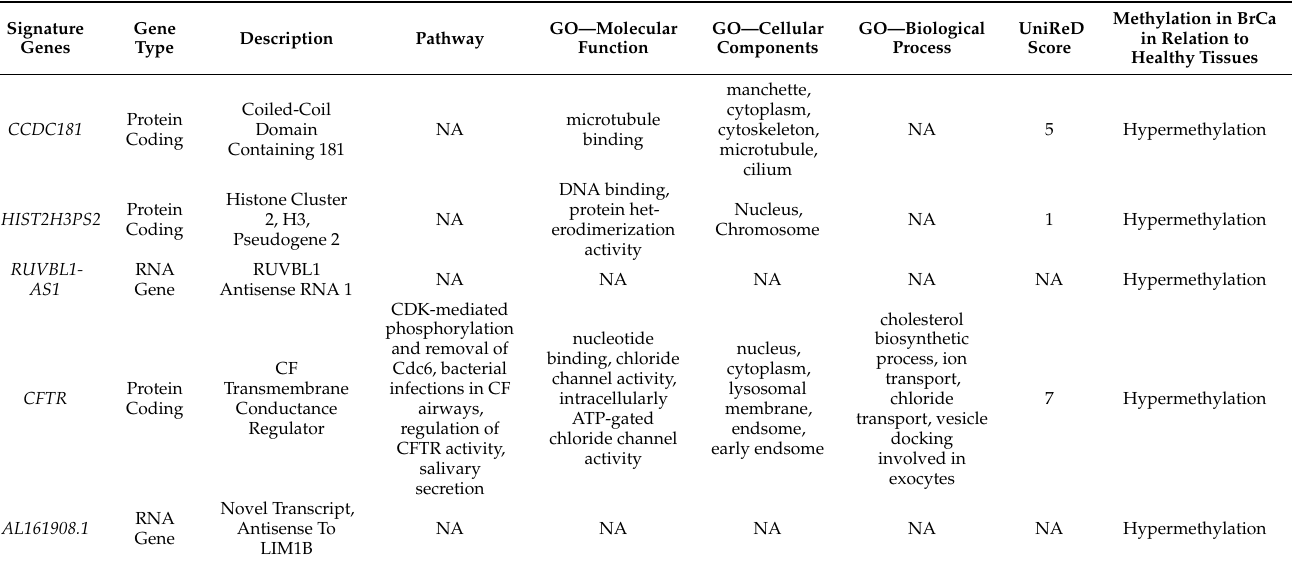
Table 1. Differentially methylated genes selected in the BrCa-specific signature built using AutoML analysis. Their biological characteristics and functions revealed by GO analysis as well as their methylation status are